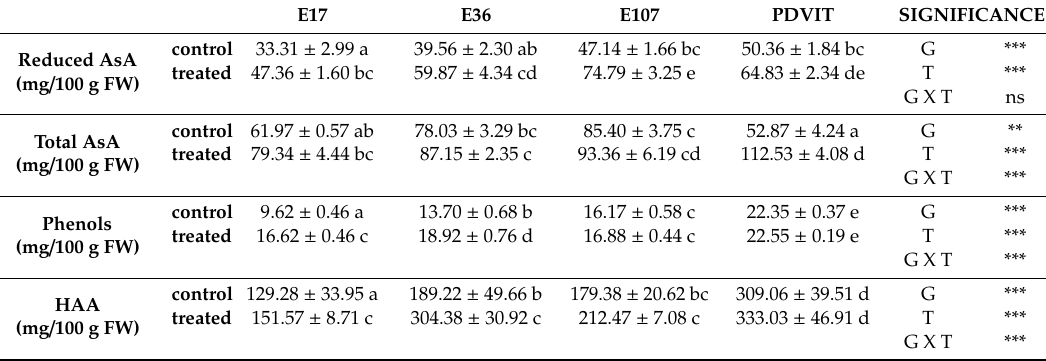
Table 3. Analyses of variance and mean comparison for reduced and total ascorbic acid (AsA), total phenols, hydrophilic antioxidant activities (HAA) in fruits of di ff erent tomato cultivars treated with the biostimulant CycoFlow applied by fertirrigation four times. Means ± SD within rows and columns followed by the di ff erent letter are significantly di ff erent based on Tukey-HSD test ( p ≤ 0.05). E17 E36 E107 PDVIT